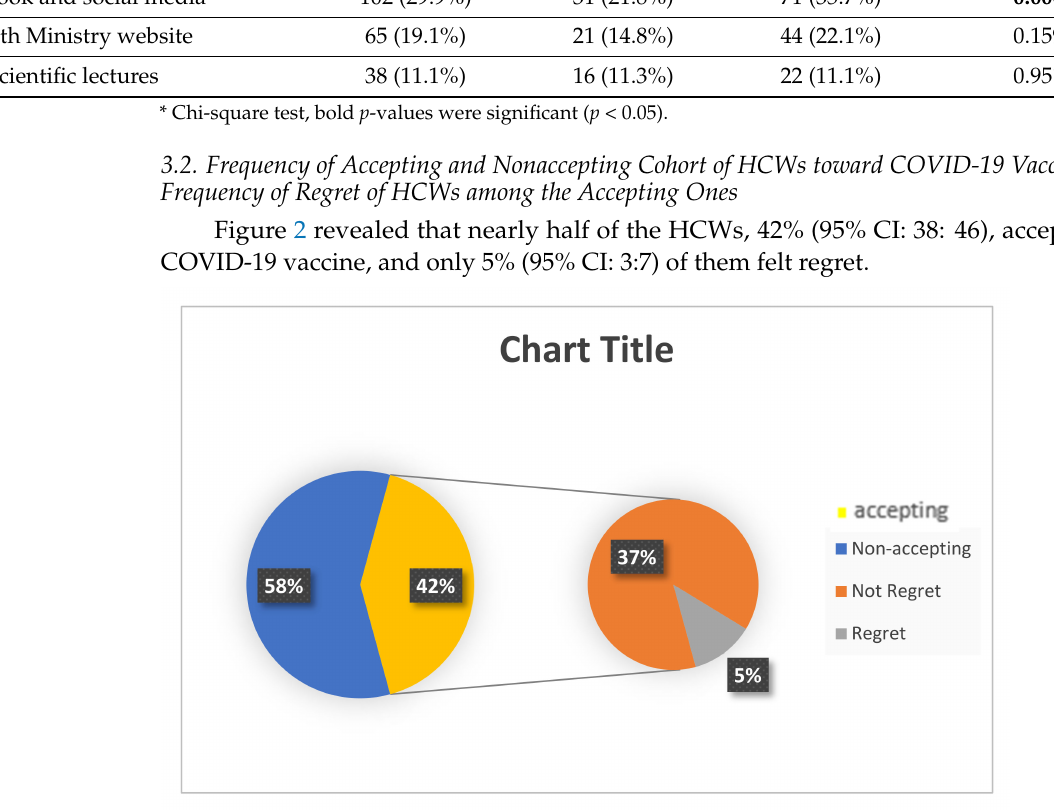
Figure 2. Frequency of accepting and nonaccepting cohort HCWs toward COVID-19 vaccine, and frequency of regret among the accepting